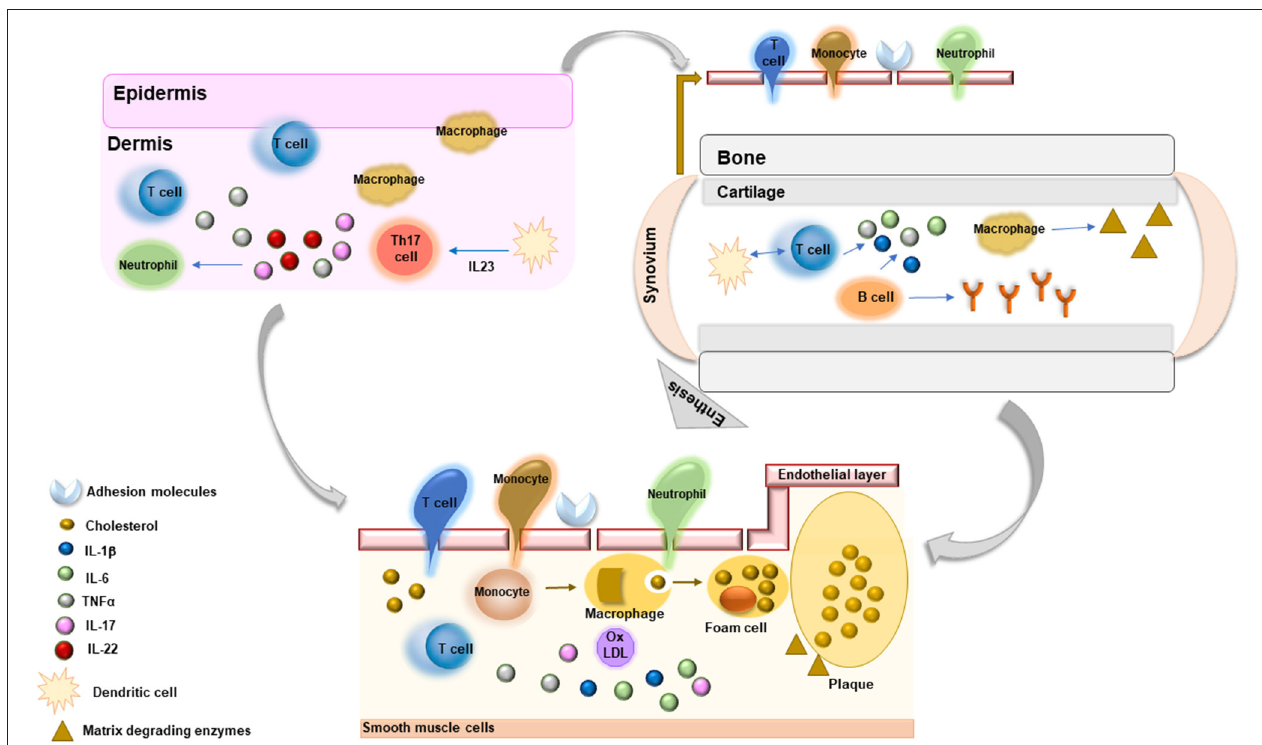
FIGURE 1 | Common inflammatory mechanisms driving the pathogenesis of chronic rheumatic diseases and athrosclerosis.